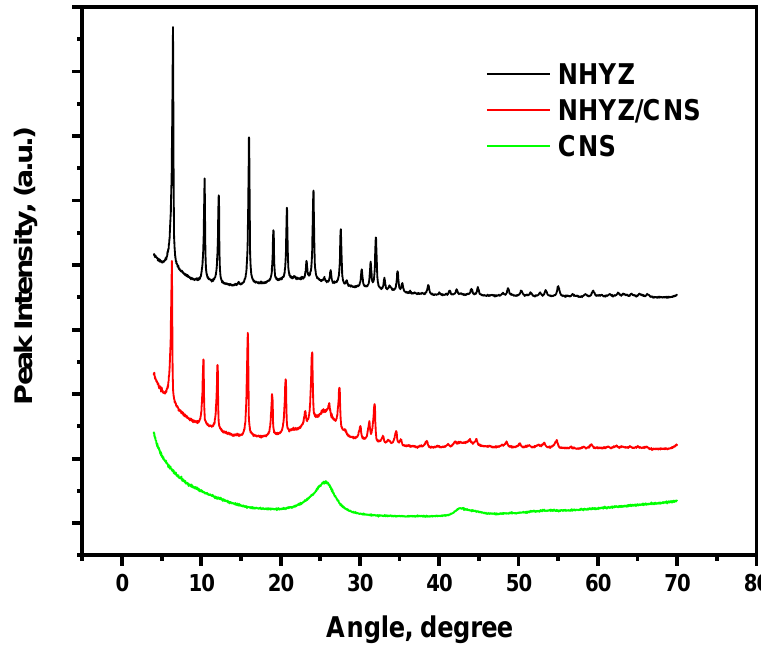
Figure 4. XRD graph of NHYZ, CNS, and NHYZ / CNS.